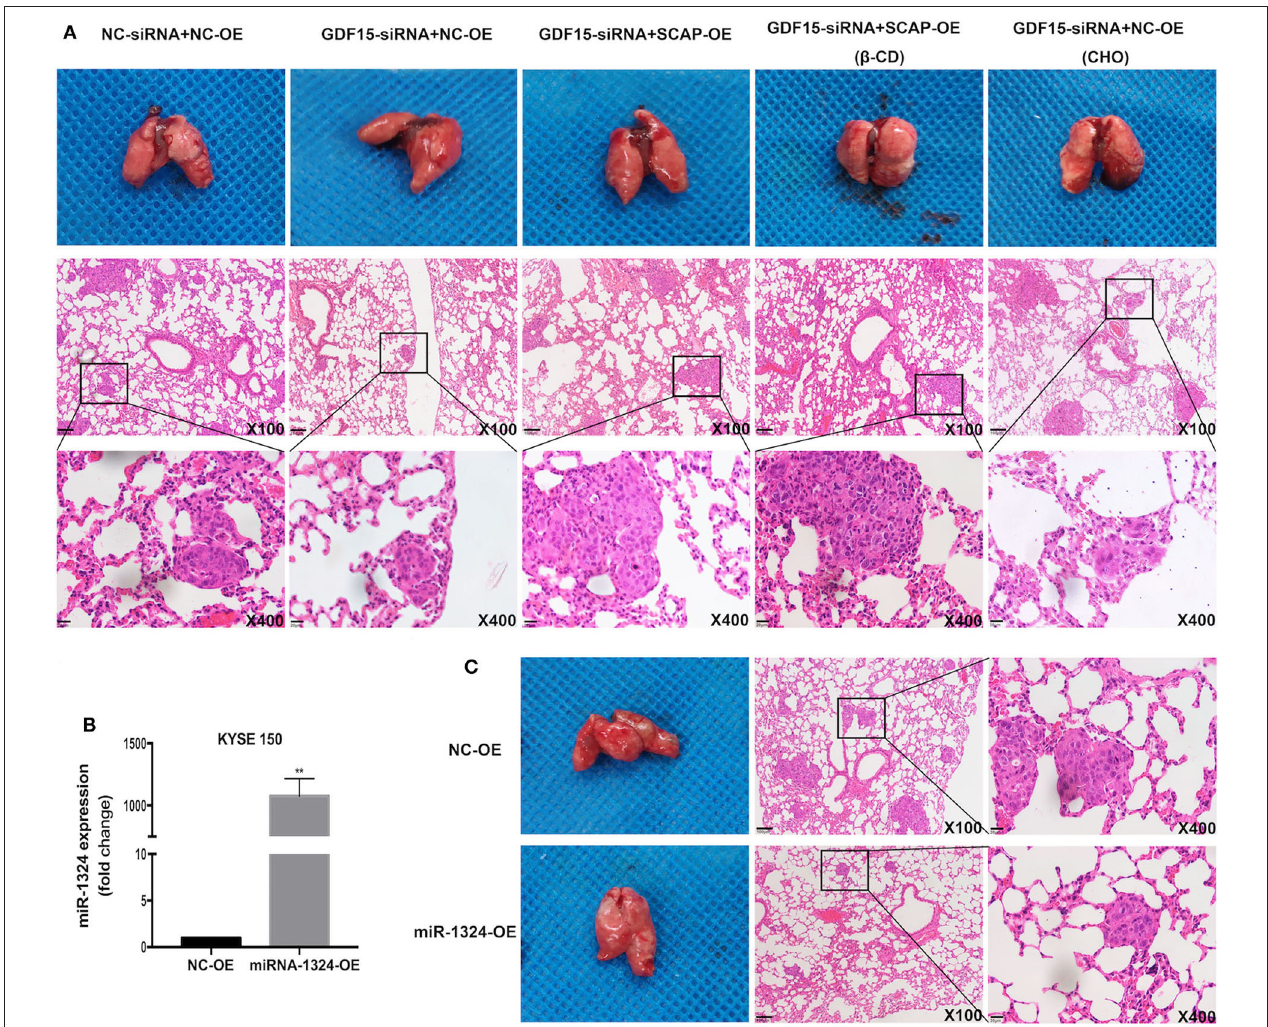
FIGURE 6 | SCAP mediated GDF15-induced lung metastasis of KYSE 150 via cholesterol metabolism. (A) Reduced lung metastasis was observed in mice transplanted with GDF15 knockdown KYSE 150 cells, which was reversed by SCAP overexpression or high cholesterol diet. Lung metastasis in transplanted SCAP overexpressing cells was partially reduced by intraperitoneal injection of β -CD (0.5 g/kg). (B) MiR-1324 expression in KYSE 150 cells transfected with lentivirus overexpressing miR-1324 determined by RT-PCR. (C) Mice injected with KYSE 150 cells transfected with lentivirus overexpressing miR-1324 had reduced lung metastasis. ** P <